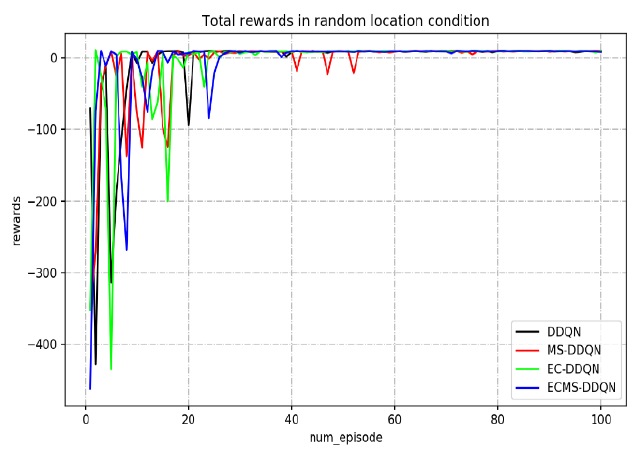
Figure 7. Return curve of four algorithms in a random environment.